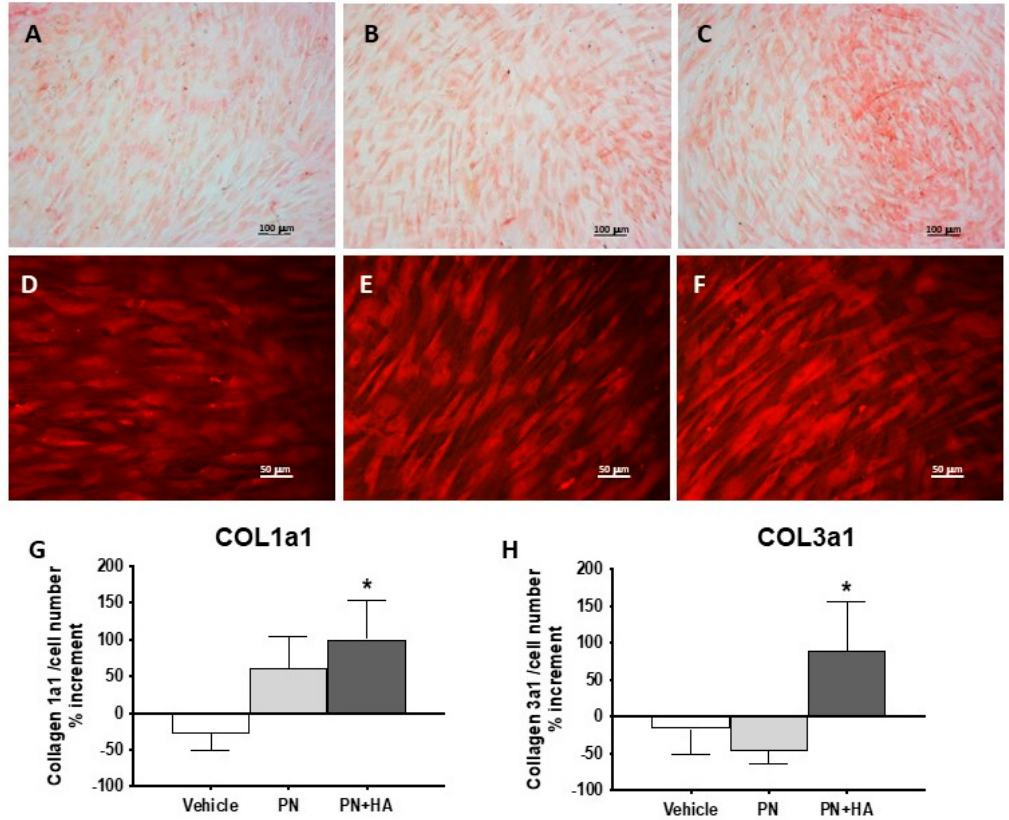
Figure 3. ( A – C ) Microphotographs of gingival fibroblasts at widefields cultured with vehicle ( A ), PN ( B ) or PN + HA ( C ) and stained with Sirius red. Bar = 100 µ m. ( D – F ) Microphotographs of fibroblasts stained with Sirius red, under a fluorescence microscope. Bar = 50 µ m. ( G , H ) Collagen 1a1 ( G ) and Collagen 3a1 ( H ) expression in culture supernatants of fibroblasts in control group or in the presence of PN or PN + HA, expressed as % increase in Collagen production/% increase in cell number from 96 h to 1 week of culture. PN + HA hydrogel stimulated a higher expression of Collagen 1a1 and Collagen 3a1 adjusted by cell growth. * p = 0.023 for ( G ) and * p = 0.024 for ( H